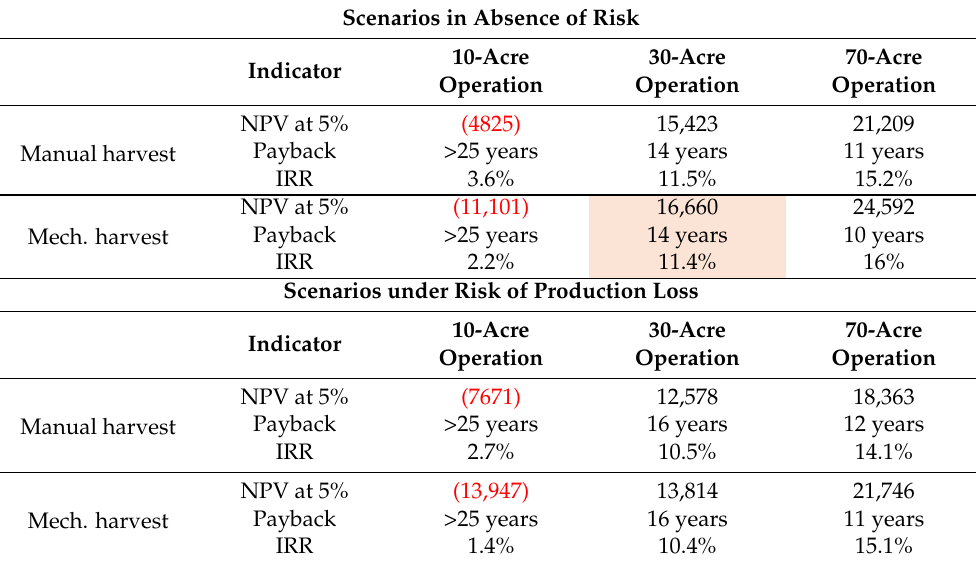
Table 10. Feasibility indicators of vinifera cultivar vineyards in 12